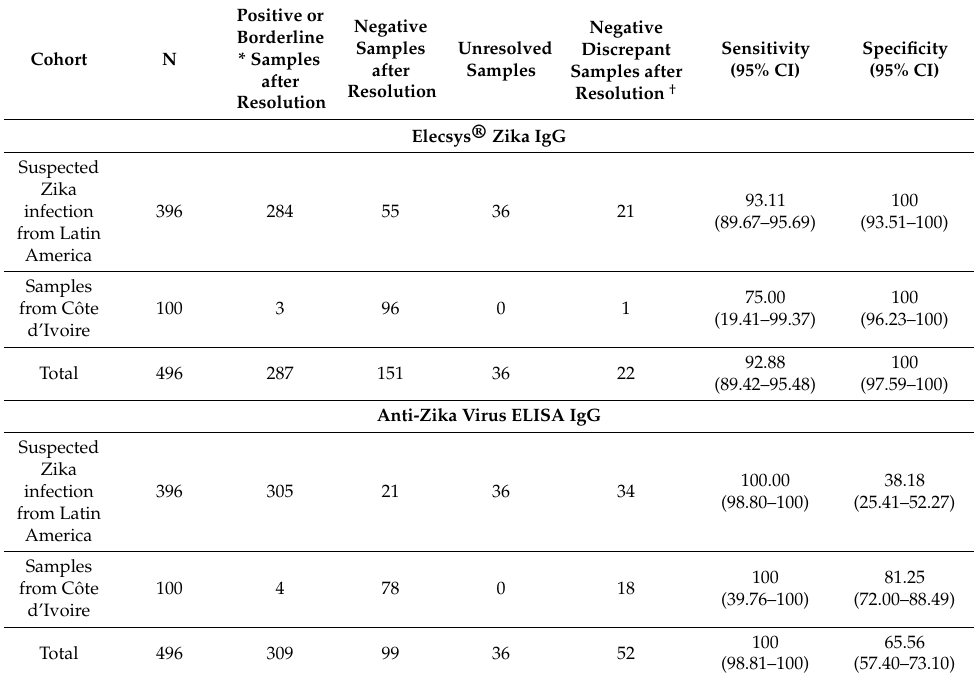
Table 1. Elecsys ® Zika IgG and anti-Zika virus ELISA IgG assay diagnostic sensitivity and specificity in samples from endemic areas.